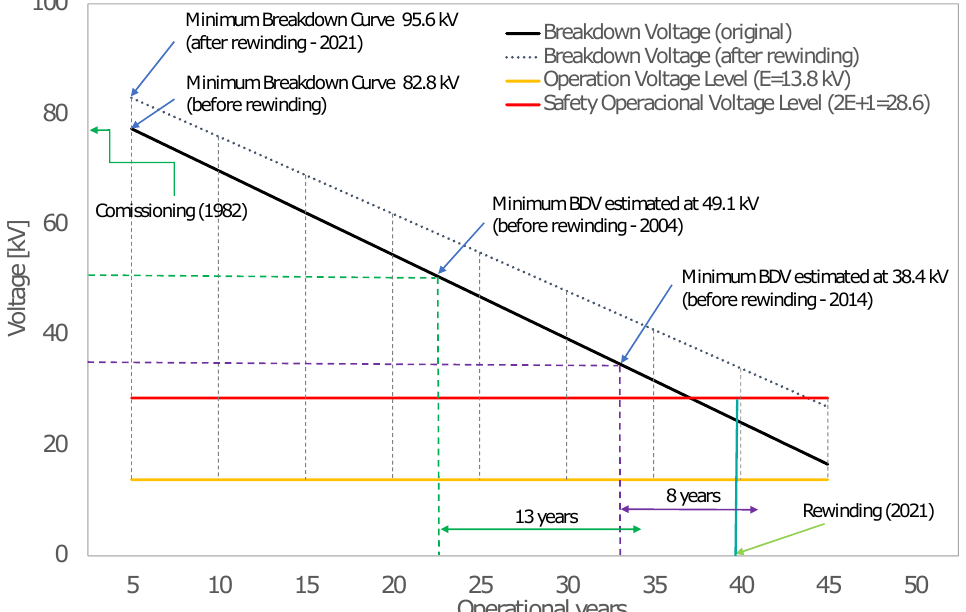
Figure 8. Residual life of Chivor II generator unit 5 before and after rewinding.